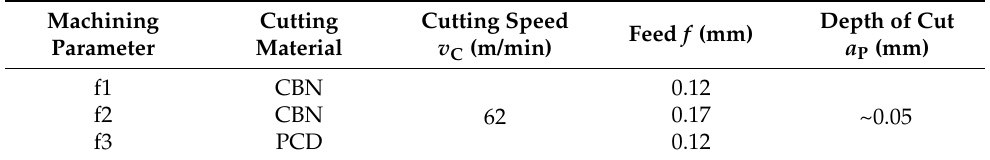
Table 2. Machining parameters for coatings